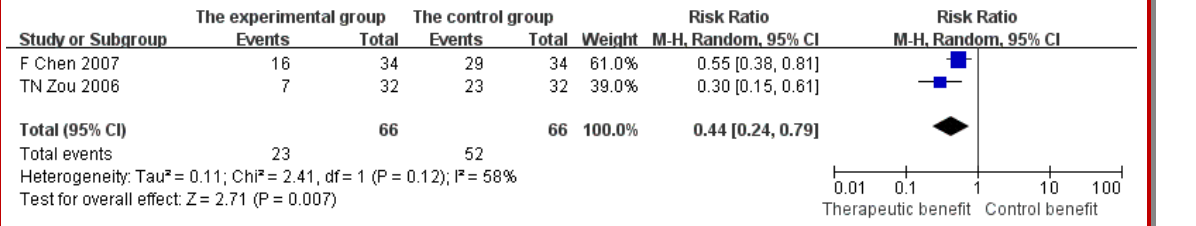
Figure 5: The fatigue of SI in treatment of breast cancer with